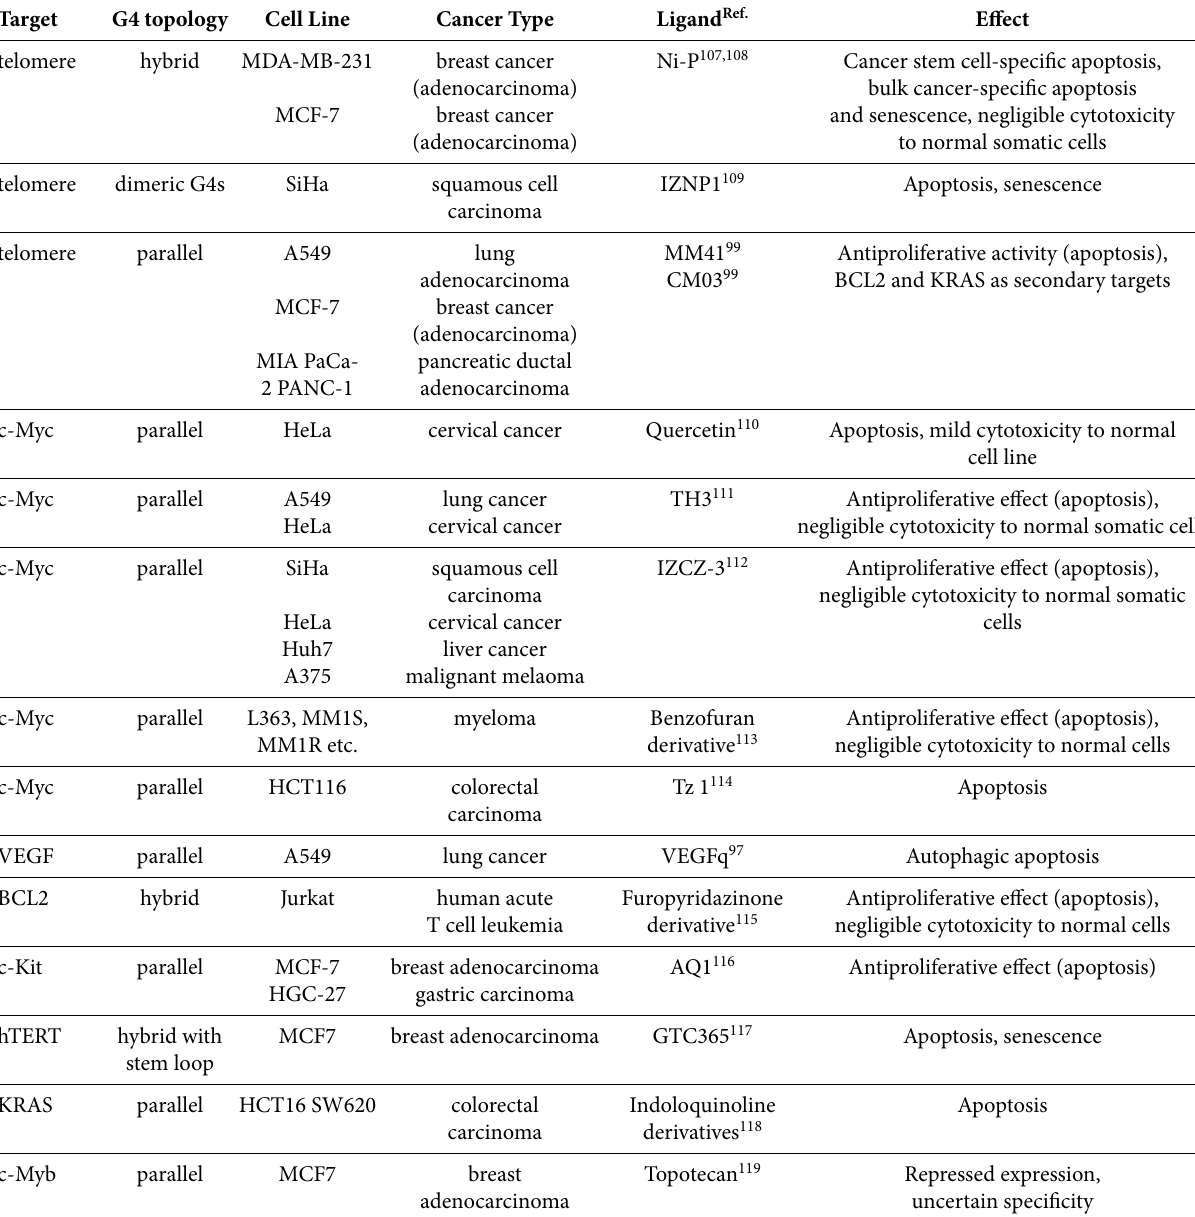
Table 1. G4 ligands with anti-cancer activities. Updated data reported previously. 43